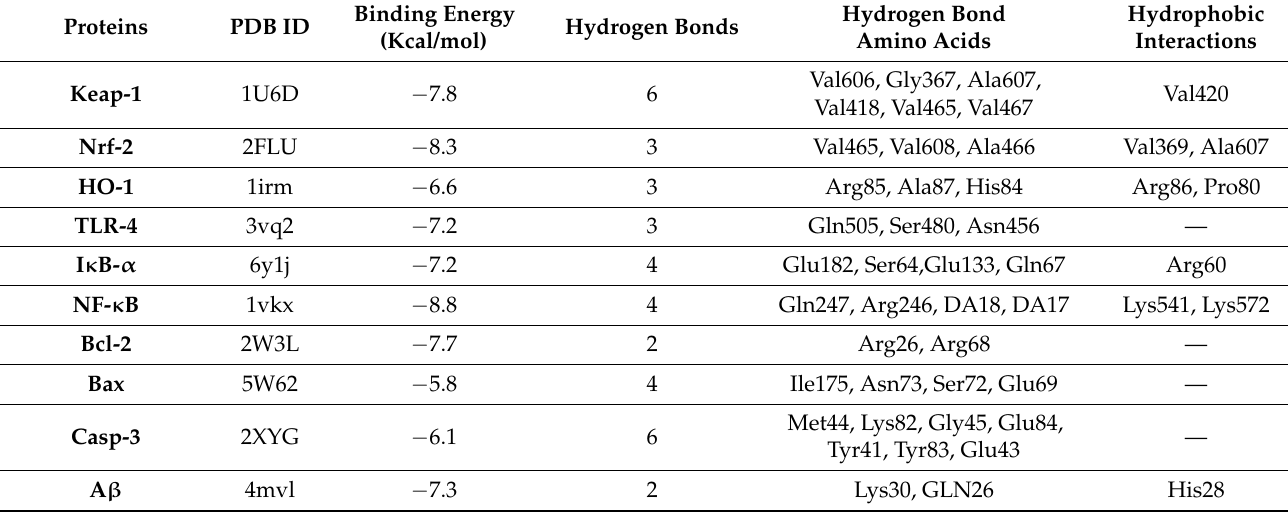
Figure 13. Molecular docking analysis of Bergenin with the active site of protein targets. ( A ) Three dimensional (3D) and ( B ) Two dimensional (2D) structural arrangement ( a ) Kelch-like ECH-associated protein (Keap1), ( b ) Nuclear factor erythroid 2-related factor 2 (Nrf-2), ( c ) Heme oxygenase (HO-1), ( d ) Toll-like receptors (TLR-4), ( e ) nuclear factor of kappa B inhibitor, alpha (I κ B- α ), ( f ) Nuclear factor kappa B (NF- κ B), ( g ) B-cell lymphoma 2 (Bcl-2), ( h ) Bcl-2 associated X protein (Bax), ( i ) Caspase-3 (Casp-3), and ( j ) Amyloid beta (A β ). ( B ) Binding energy (K cal/mol) scores were presented by Heatmap with multiple targets, i.e., Bax, Caspase-3, I κ B- α , HO-1, TLR-4, Bcl-2, Keap-1, NF- κ B, Nrf-2 and A β . Table 3. Molecular docking analysis of Bergenin.